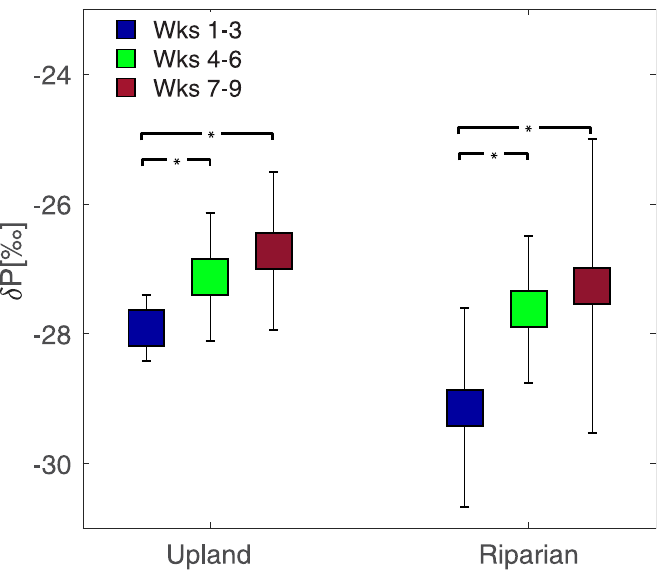
Fig 3. Seasonal evolution of δ P across upland and riparian soil plots. Squares denote means across upland (n = 23) and riparian (n = 9) sites, whereas error bars denote standard deviations. Asterisks denote statistical differences between different sampling periods (p < 0.05, Wilcoxon rank sum test).